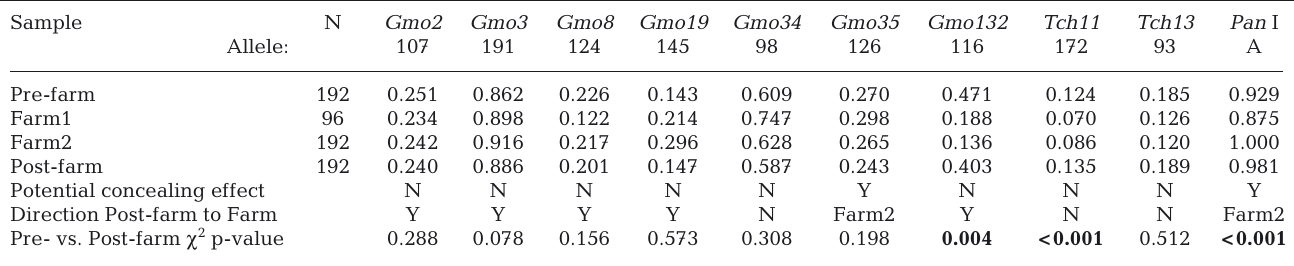
Table 8. Number of genotyped Atlantic cod individuals, and frequency of the most common allele at DNA marker loci in the samples. ‘Potential concealing effect’ is the possibility of a concealing effect when the 2 farmed samples display both higher and lower frequency values than Pre-farm (Y = yes, N = no). ‘Direction Post-farm to Farm’ denotes whether the allele frequency in the Post sample is as expected if caused by farmed cod. ‘Pre vs. Post-farm χ 2 p-value’ denote p-value from Chi-square test for pooled alternative alleles at each